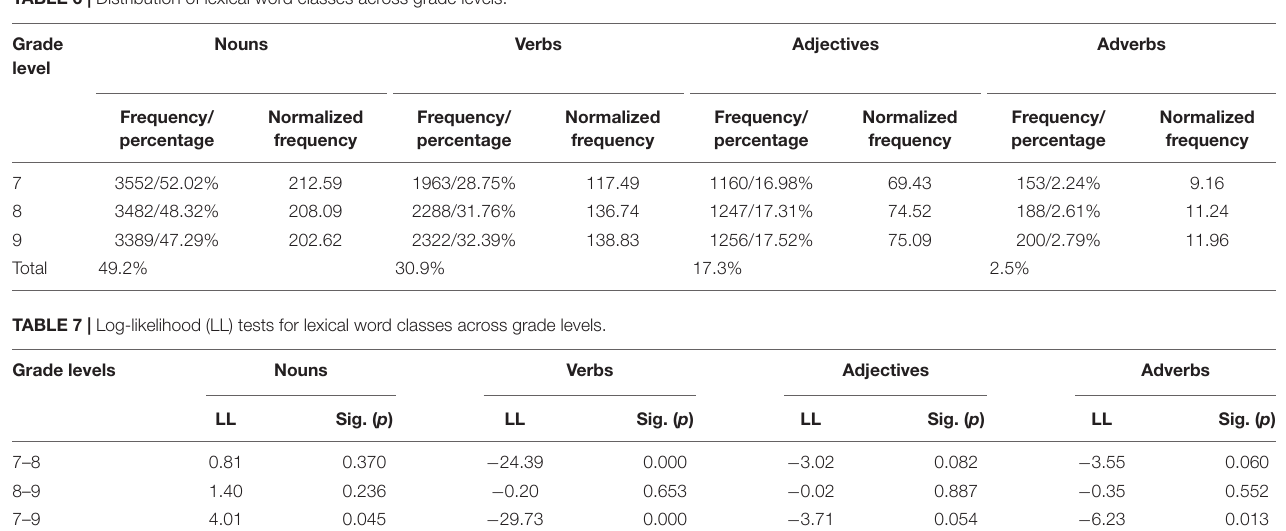
TABLE 6 | Distribution of lexical word classes across grade levels.